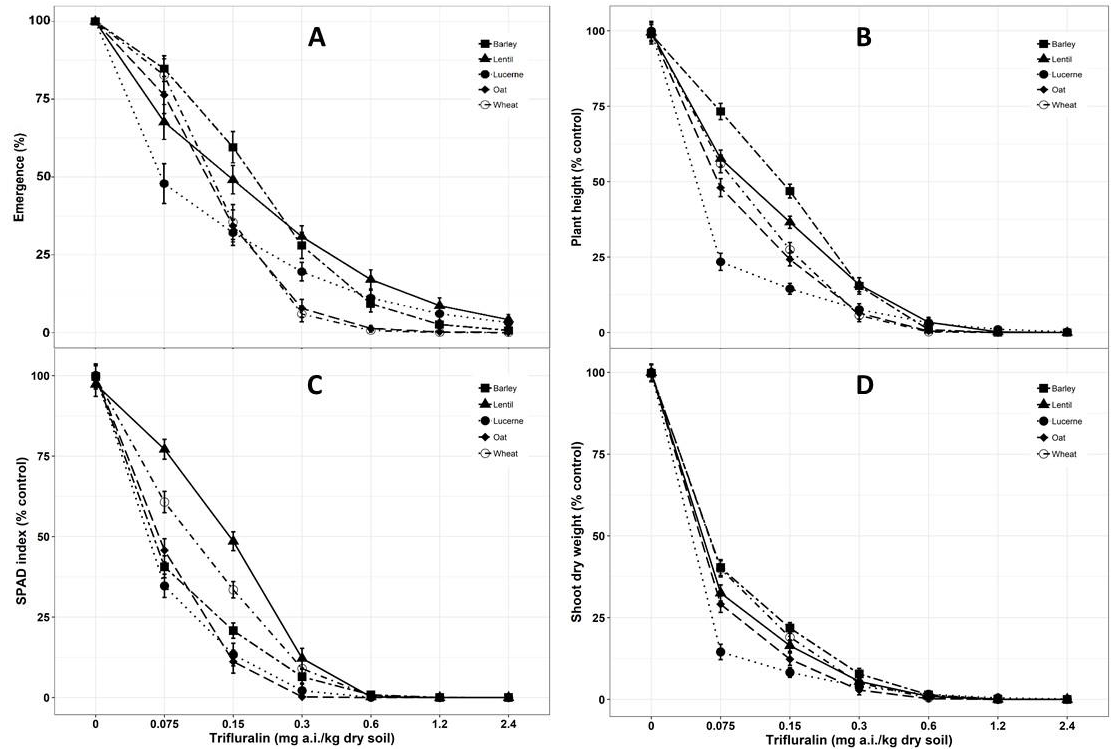
Figure 1. Dose-response effects of trifluralin on shoot parameters ( A . Emergence; B . Plant height; C . SPAD index; D . Shoot dry weight) of barley, lentil, lucerne, oat and wheat at 28 days after sowing (DAS). Lines denote predicted responses according to the equations reported in the materials and methods section. Symbols shown on the graphs are the original means of each parameter (% control) against each dose of trifluralin concentration. Mean value was pooled from eight observational units.